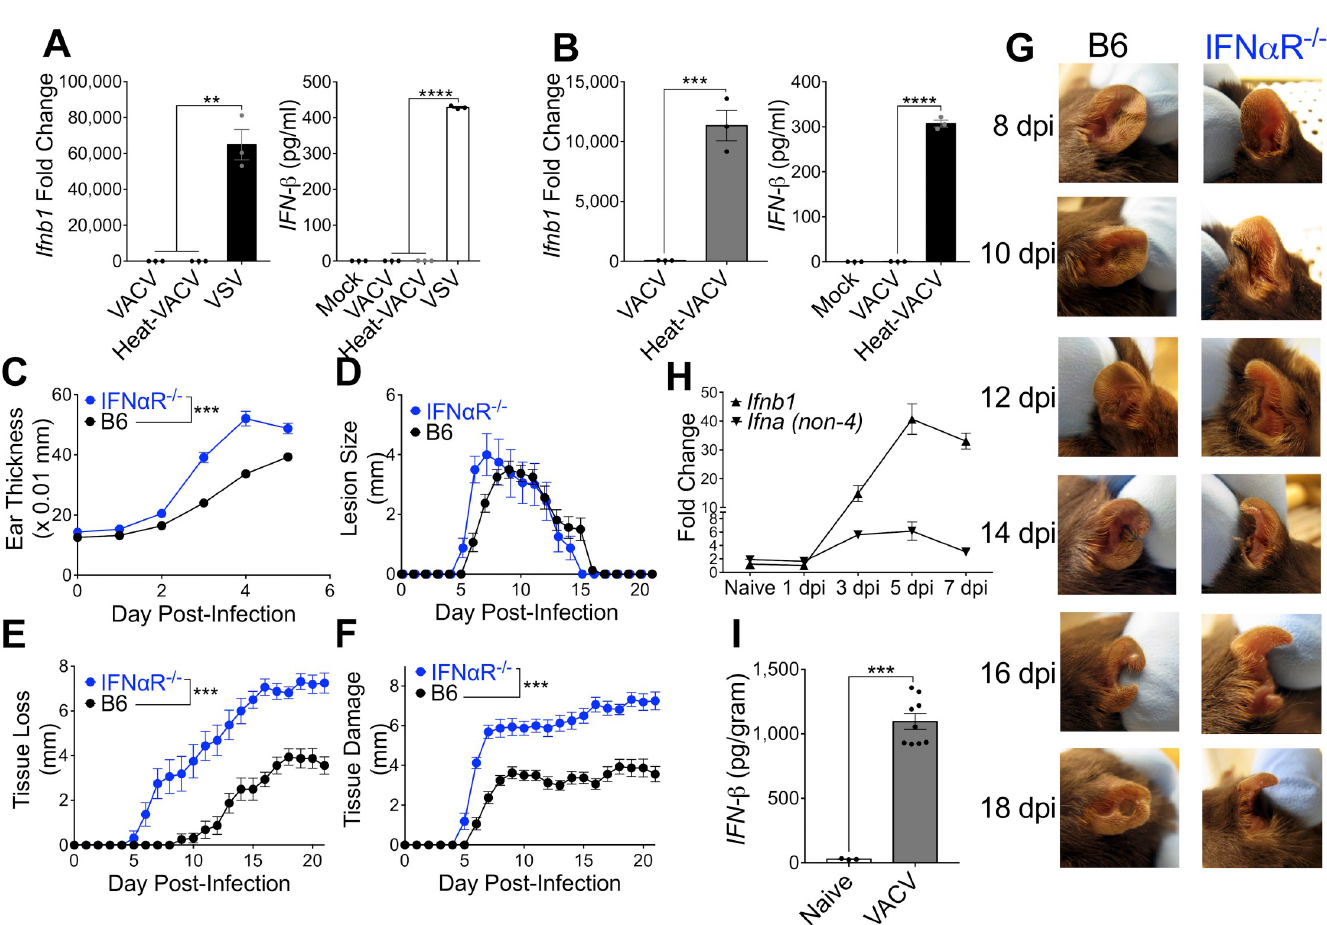
Fig 1. T1-IFN is not expressed within infected cells in vitro , but T1-IFN expression is required in vivo . (A,B) Expression of IFN- β from a murine keratinocyte (A) or macrophage (B) cell line measured by RT-qPCR 6 hpi (left) or ELISA 24 hpi (right). (C-F) Tissue pathology of the ear pinnae after intradermal infection with VACV; ear thickness (C), lesion size (D), tissue loss (E), or total tissue damage (F), n = 8 mice per group. (G) Representative pictures of ear pinnae following intradermal VACV infection. (H,I) Expression of T1-IFN in ear tissue of wild-type mice at the indicated time post-infection measured by RT-qPCR (H, n = 3 na ï ve, 4 VACV- infected mice per group), or 5 dpi by ELISA